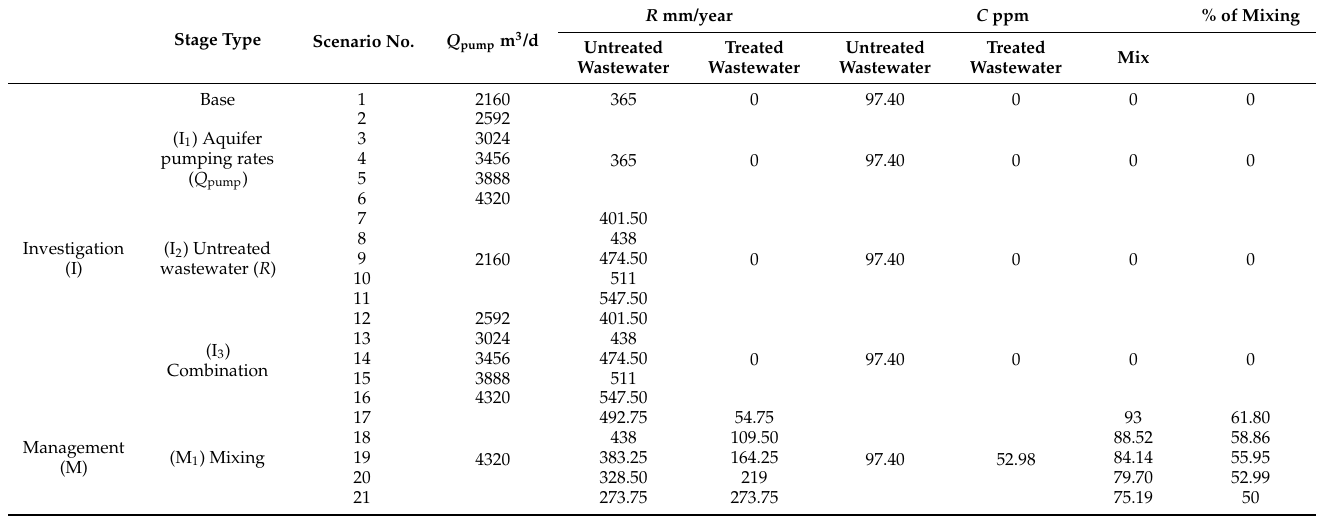
Table 2. Proposed scenarios for untreated wastewater with mixing by treated wastewater. Stage